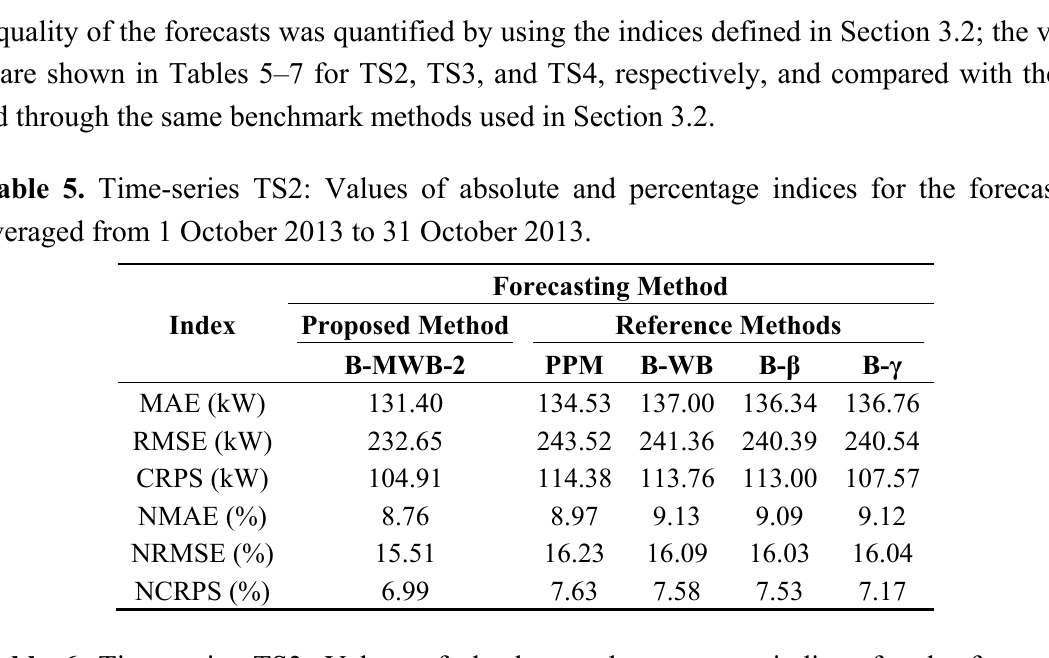
Table 6. Time-series TS3: Values of absolute and percentage indices for the forecasts averaged from 1 October 2013 to 31 October